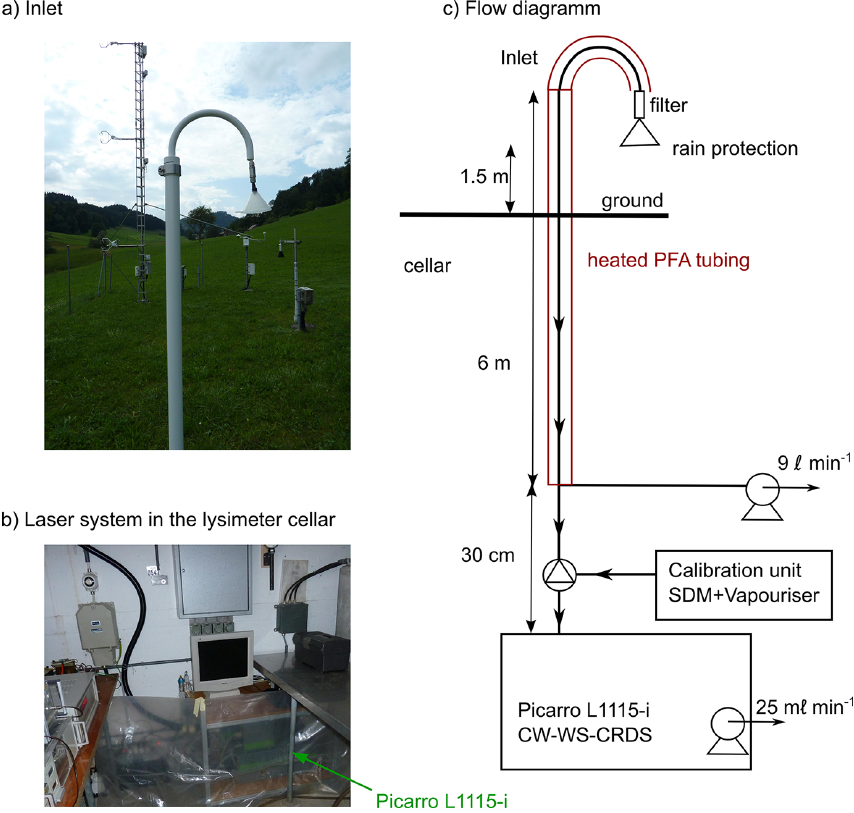
Fig. 2. Setup of the laser spectrometer at the Büel measurement site of the research catchment Rietholzbach. (a) Inlet of the sampling system. (b) Setup of the Picarro L1115- i cavity ring-down laser spectrometer in the cellar of the measurement field. (c) Flow diagram of the setup including the inlet and the laser spectroscopic measurement